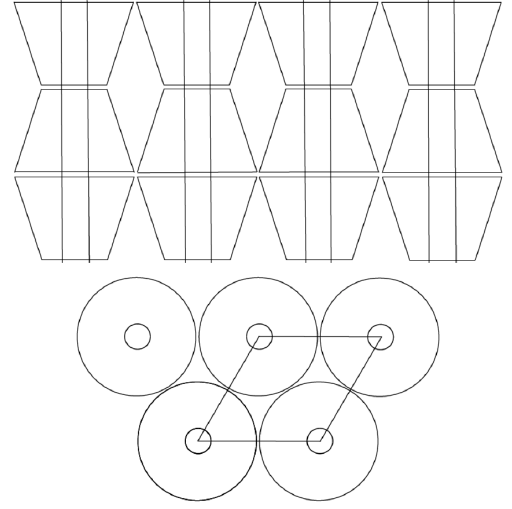
Figure 7. Channel structure of a columnar CD IC, with 0.6 ( α –CD) or 0.8 ( γ –CD) nylon-6 chains/nm 2 of CD IC crystal surface. Threaded chains are ~1.5–1.8 nm apart, so the protruding nylon-6 chains form dense polymer brushes, [12] (for comparison, in the α -form bulk crystal, there are 1.4 nylon-6 chains/nm 2 ) [8].